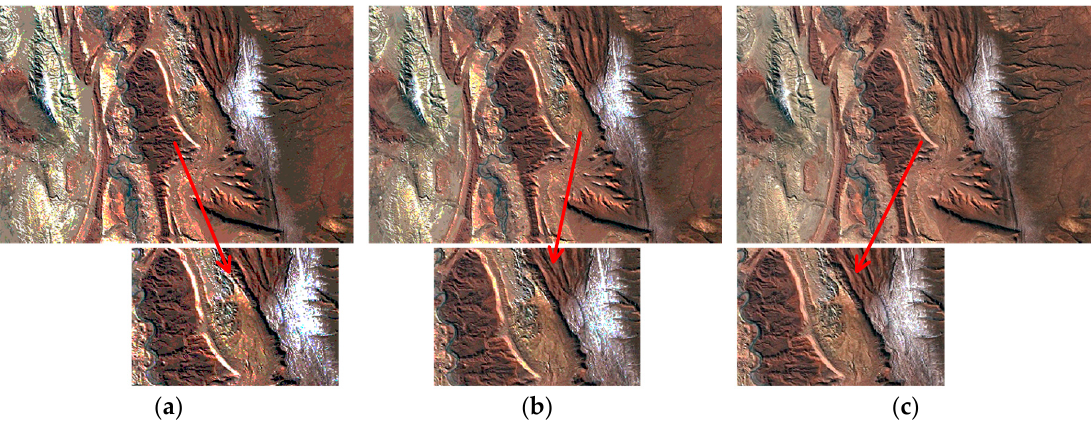
Figure 5. The segmented results and local zoom maps of “Image4” at 4, 8, and 12 threshold levels. ( a ) K = 4, ( b ) K = 8, ( c ) K = 12.